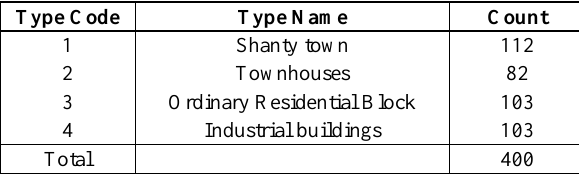
Table 1. Classes of training residential